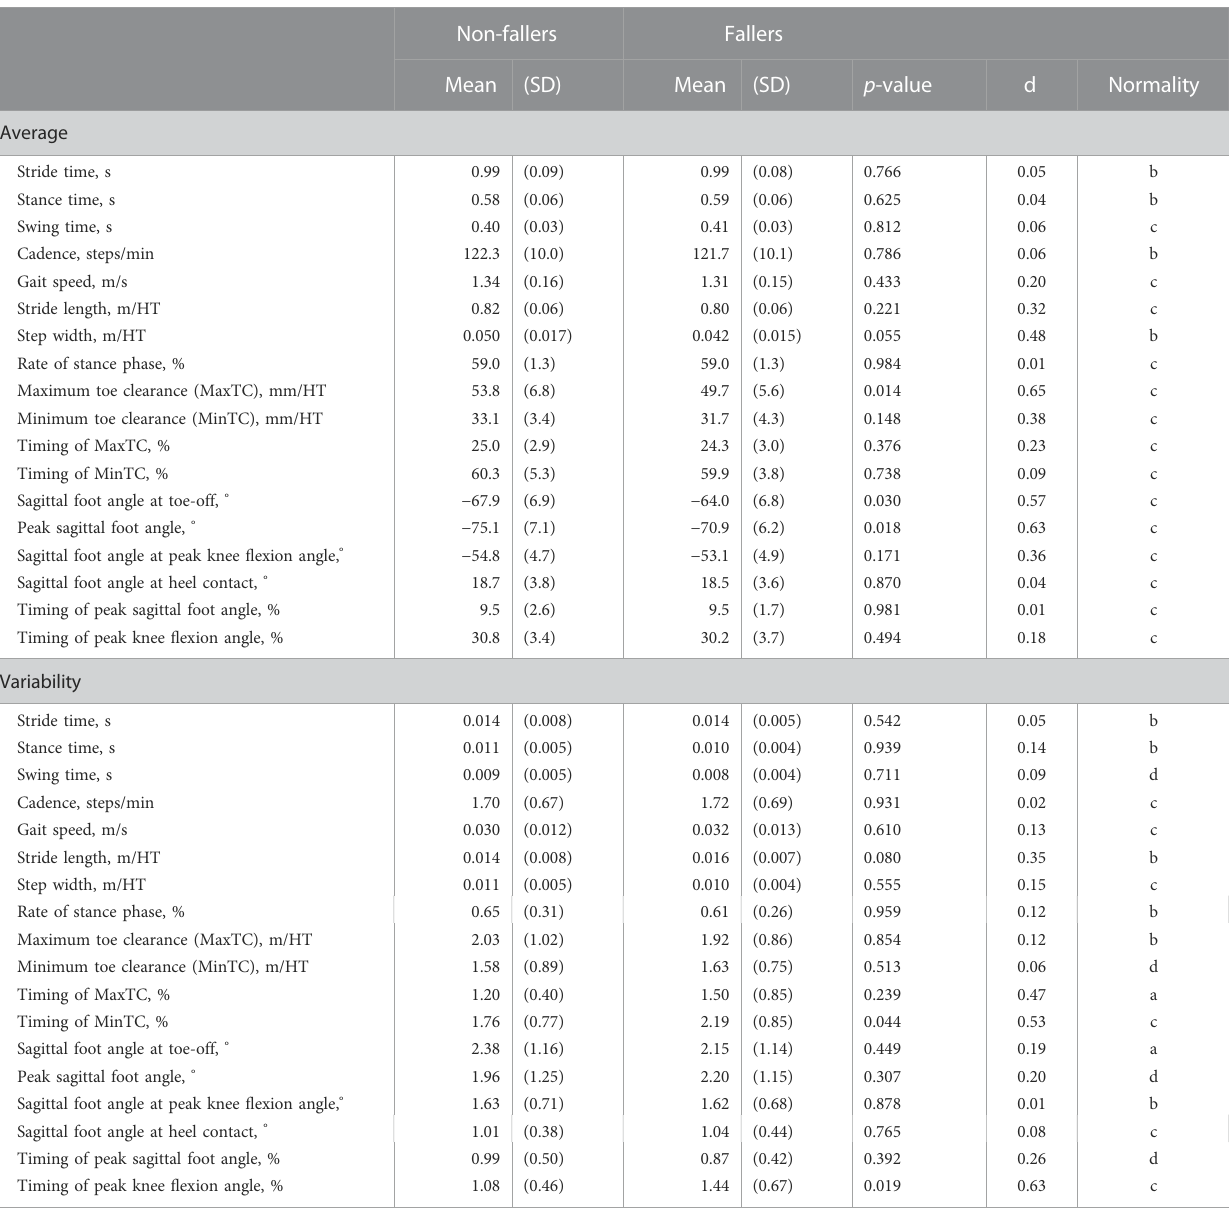
TABLE 2 Averages and variabilities of gait parameters in non-fallers and